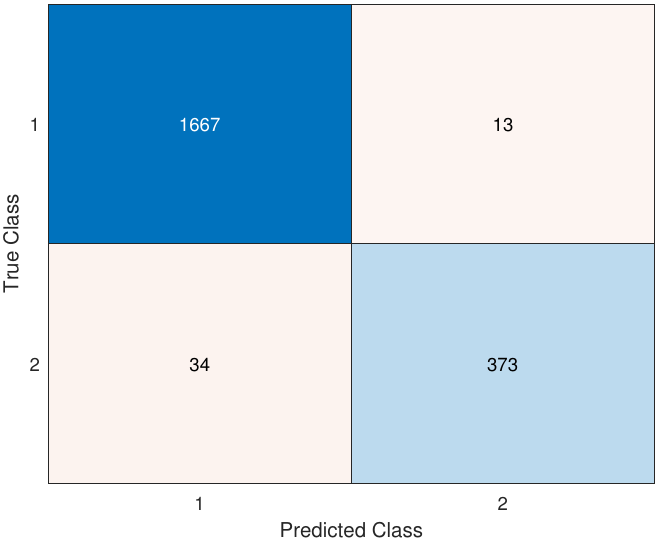
Figure 6. Confusion matrix for the test data set presenting the number of true positives and negatives on the main diagonal and the false negatives and false positives on the counterdiagonal